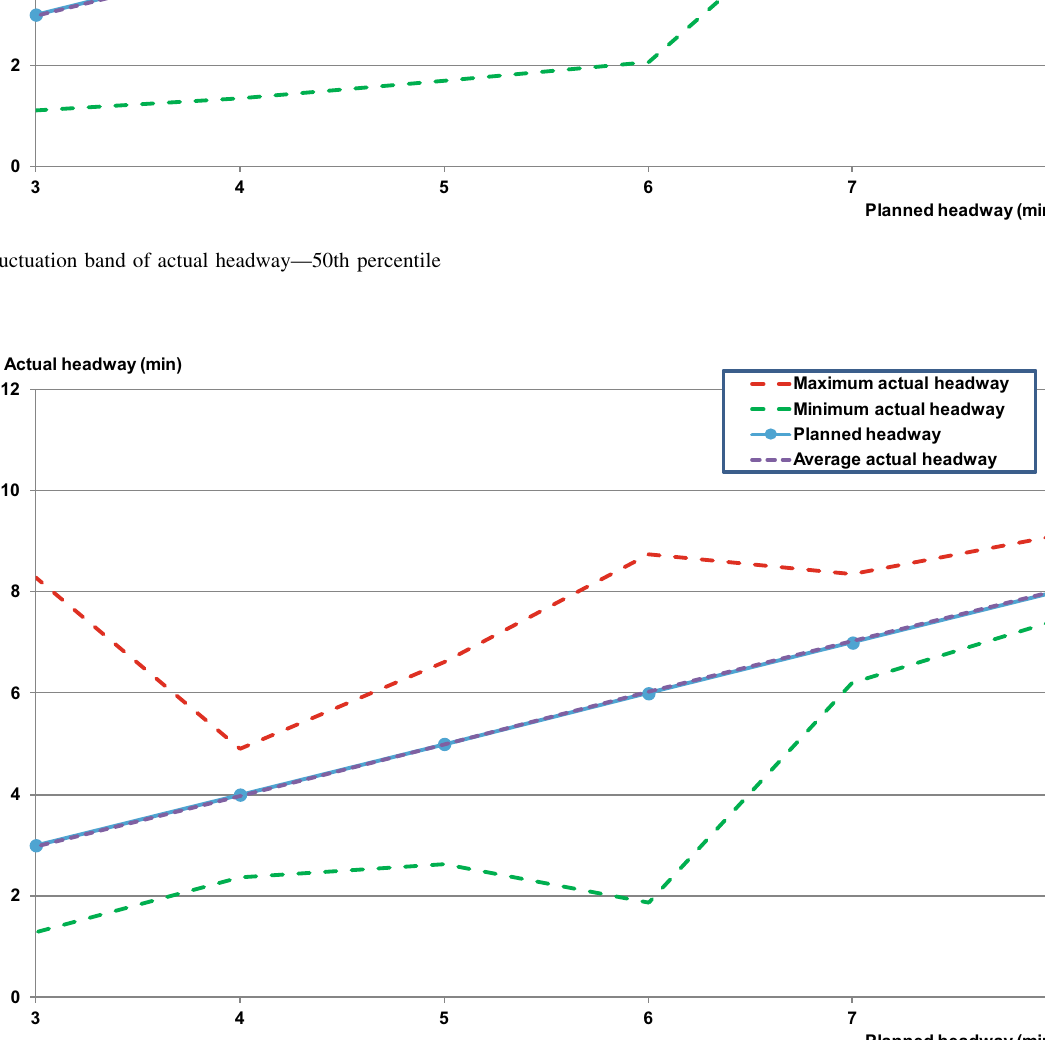
Fig. 8 Fluctuation band of actual headway—85th